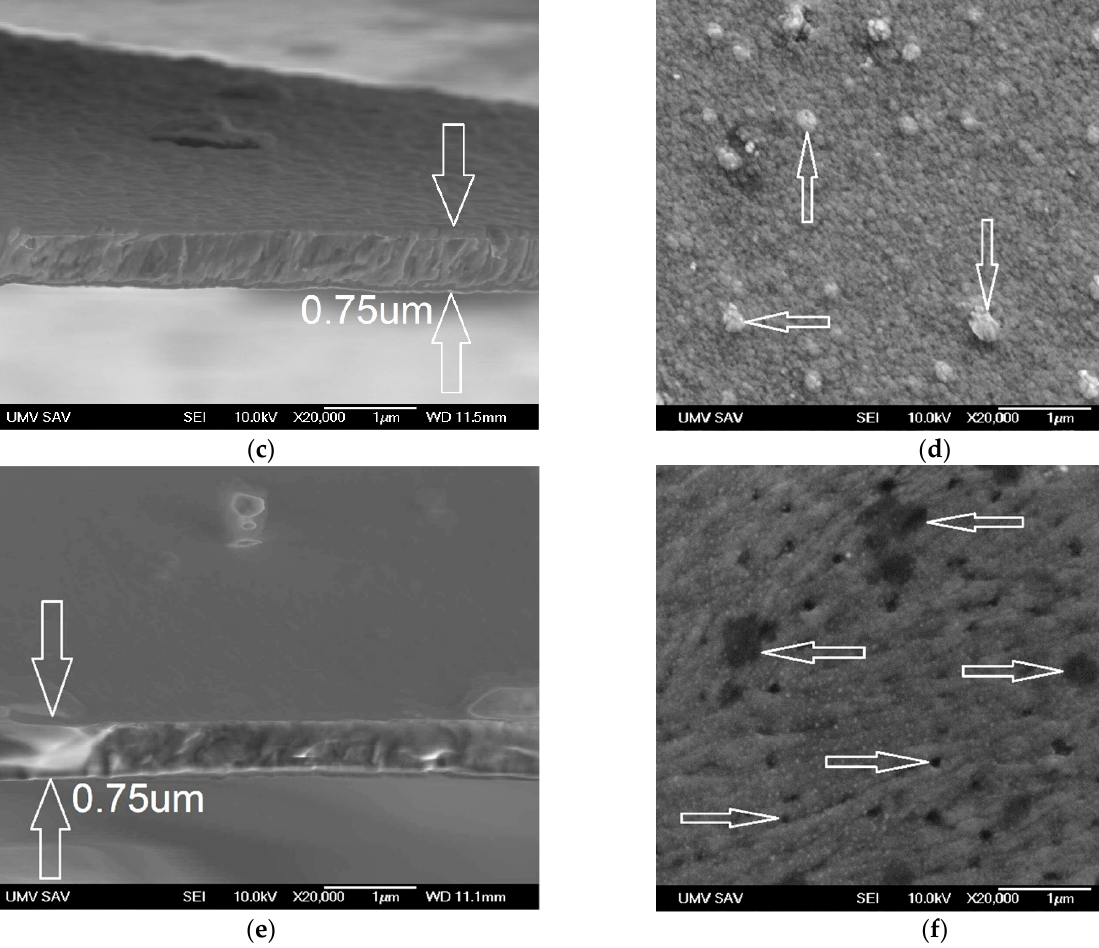
Figure 3. SEM images of the cross-sectional (left) and surface morphology (right) of WC/C coatings: ( a , d ) unannealed; ( b , e ) after annealing at 500 °C; ( c , f ) after annealing at 800 °C.